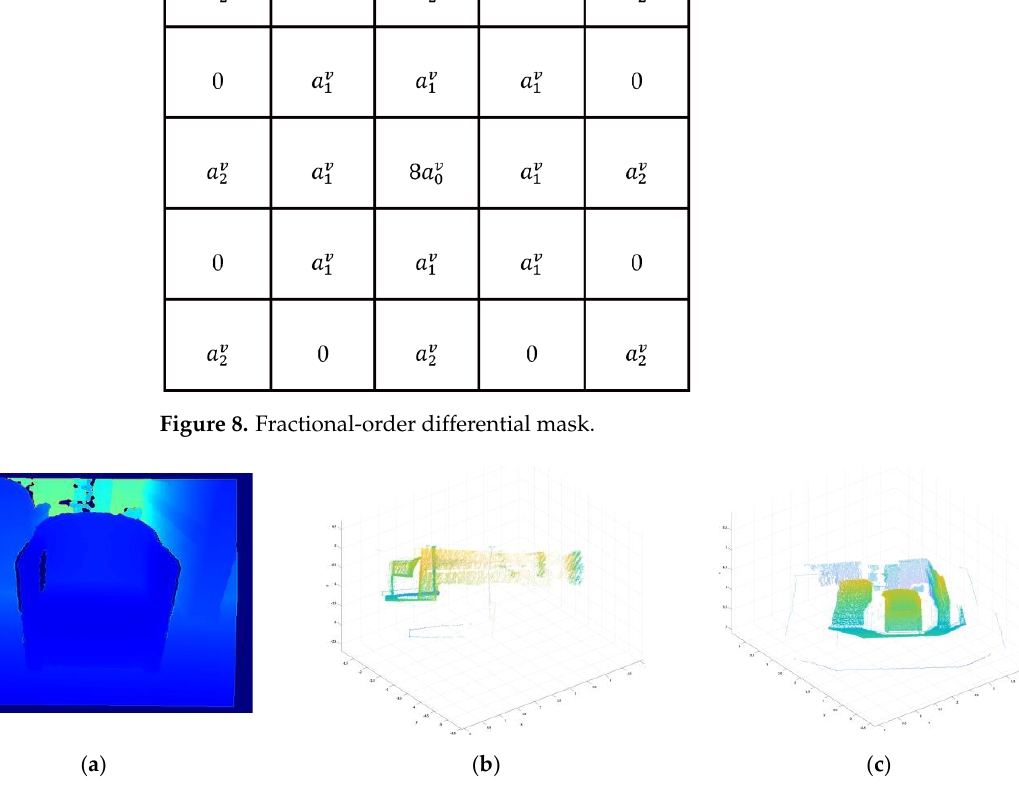
Figure 9. Fractional−order differential edge recognition for depth images. ( a ), depth image; ( b ), front view of the point cloud map of the depth image; ( c ), side view of the point cloud map of the depth image.